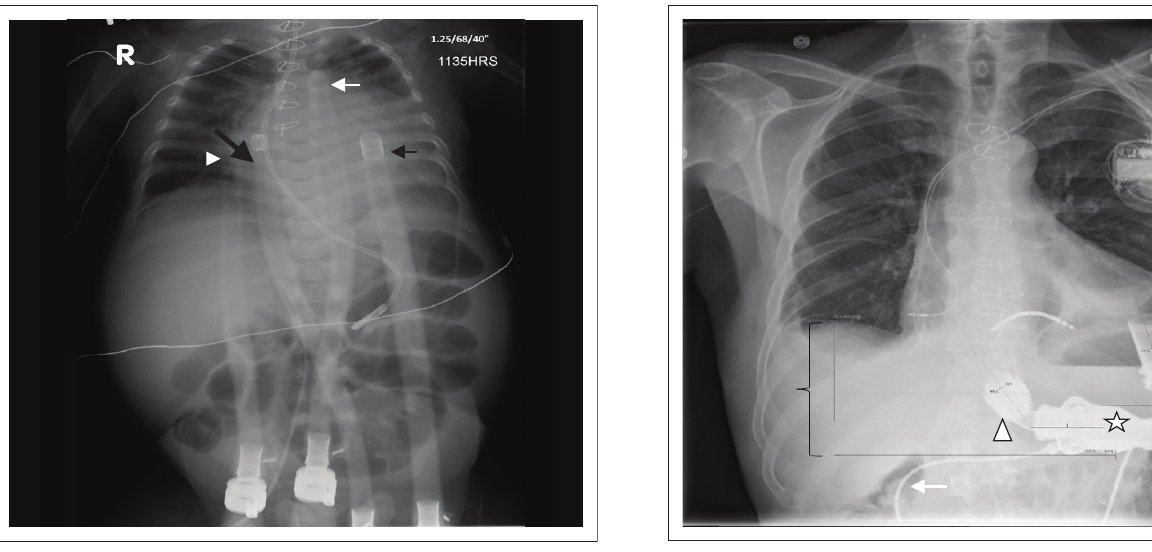
FIGURE 6: Chest radiograph showing the biventricular assist device (BIVAD) Berlin Heart placed in a 2-week-old infant with severe left ventricular dysfunction and right ventricular hypoplasia. Note the inflow (right black arrow) and outflow cannulas of the left ventricular assist device in the left ventricle and aorta, respectively, while the inflow (arrow head) and outflow (angled arrow) cannulas of the right ventricular assist device are in the right atrium and pulmonary artery, respectively.